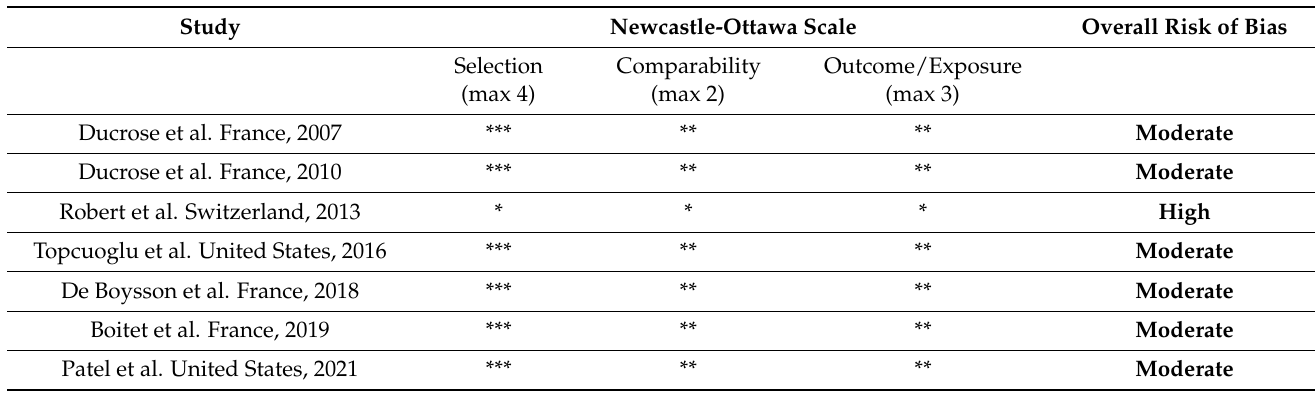
Table 2. BIAS Analysis of this